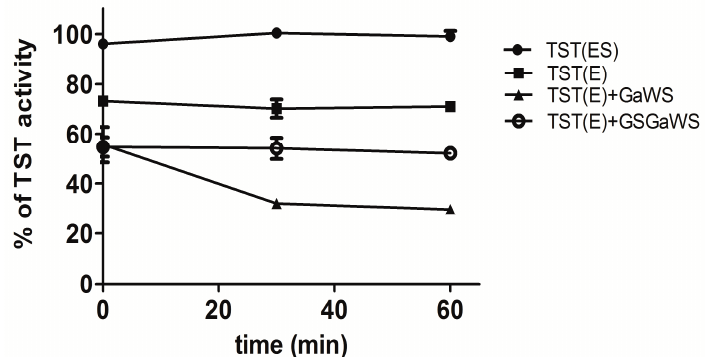
Figure 2. Inhibition of the TST-E form by water-soluble garlic extracts. The solutions were performed by addition at 11.1 μ M TST enzyme in 30 mM Tris-HCl buffer, pH 7.5, with or without 6.6 mM KCN, and 10 μ L of the GaWS or GSGaWS extracts. Five microliters of the solutions were taken from the solutions after 0, 30 and 60 min for assaying the TST